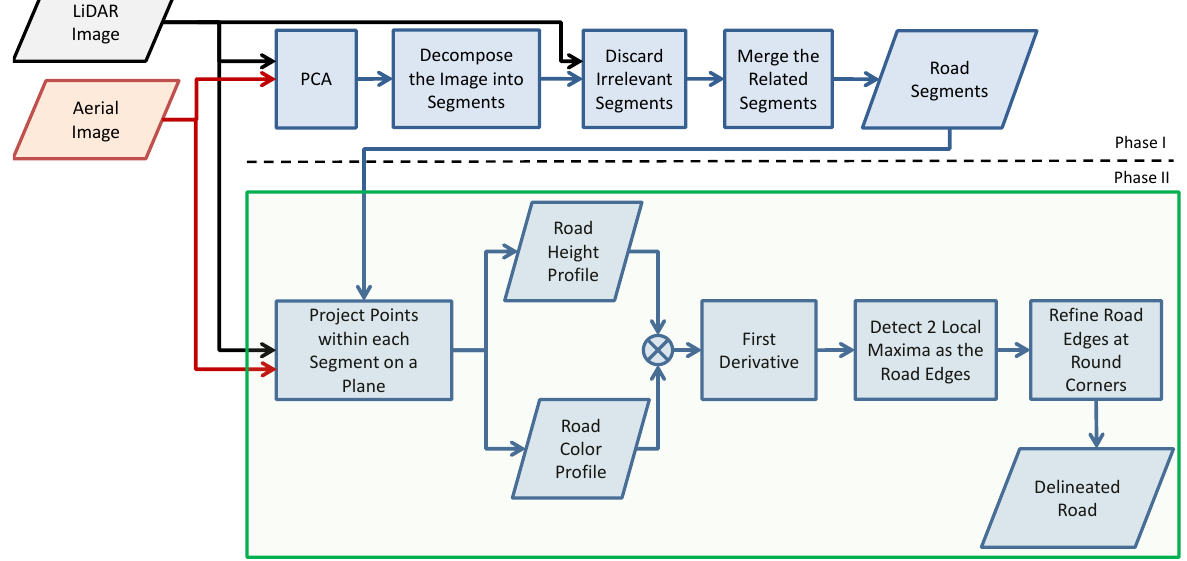
Figure 1: The overview of our proposed method; in which the process within the green rectangle is repeated for every road